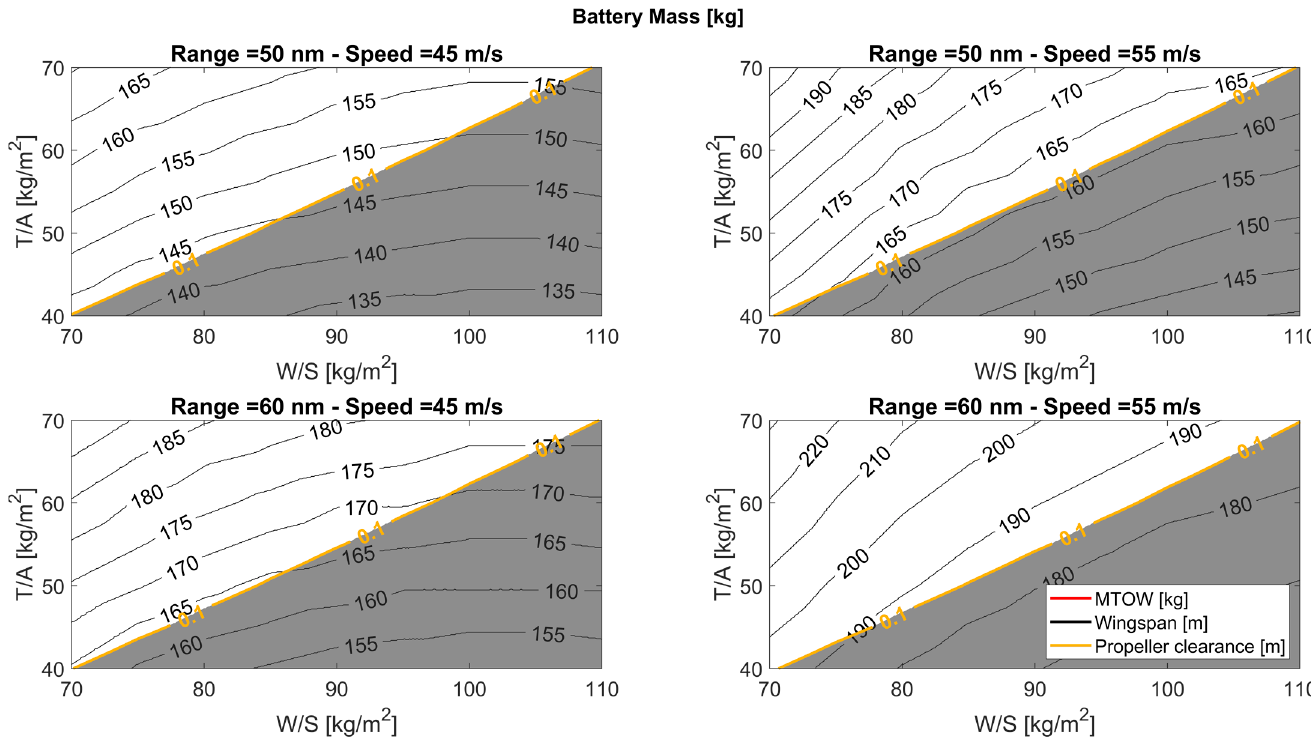
Figure 14. W/S vs. T/A charts of battery mass (future technology) varying speed and range. Each plot shows a highlighted area, which identifies the design space compliant with the constraints.